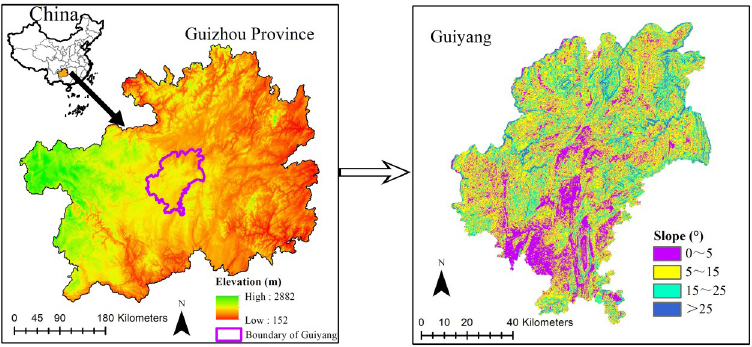
Figure 1. Location of Guiyang city